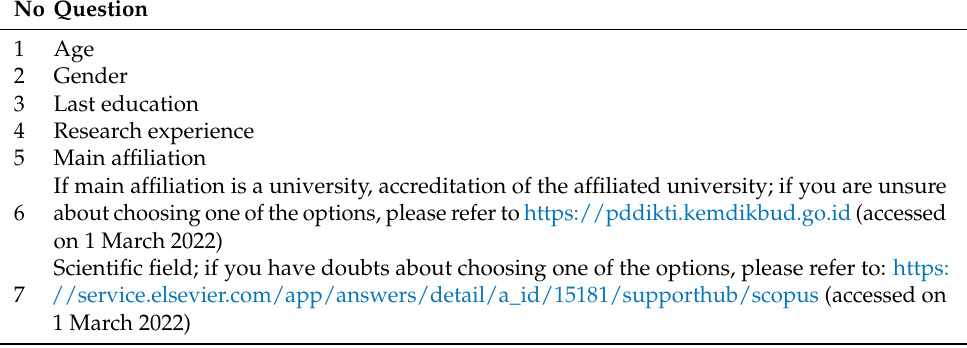
Table A1. Questionnaire: part